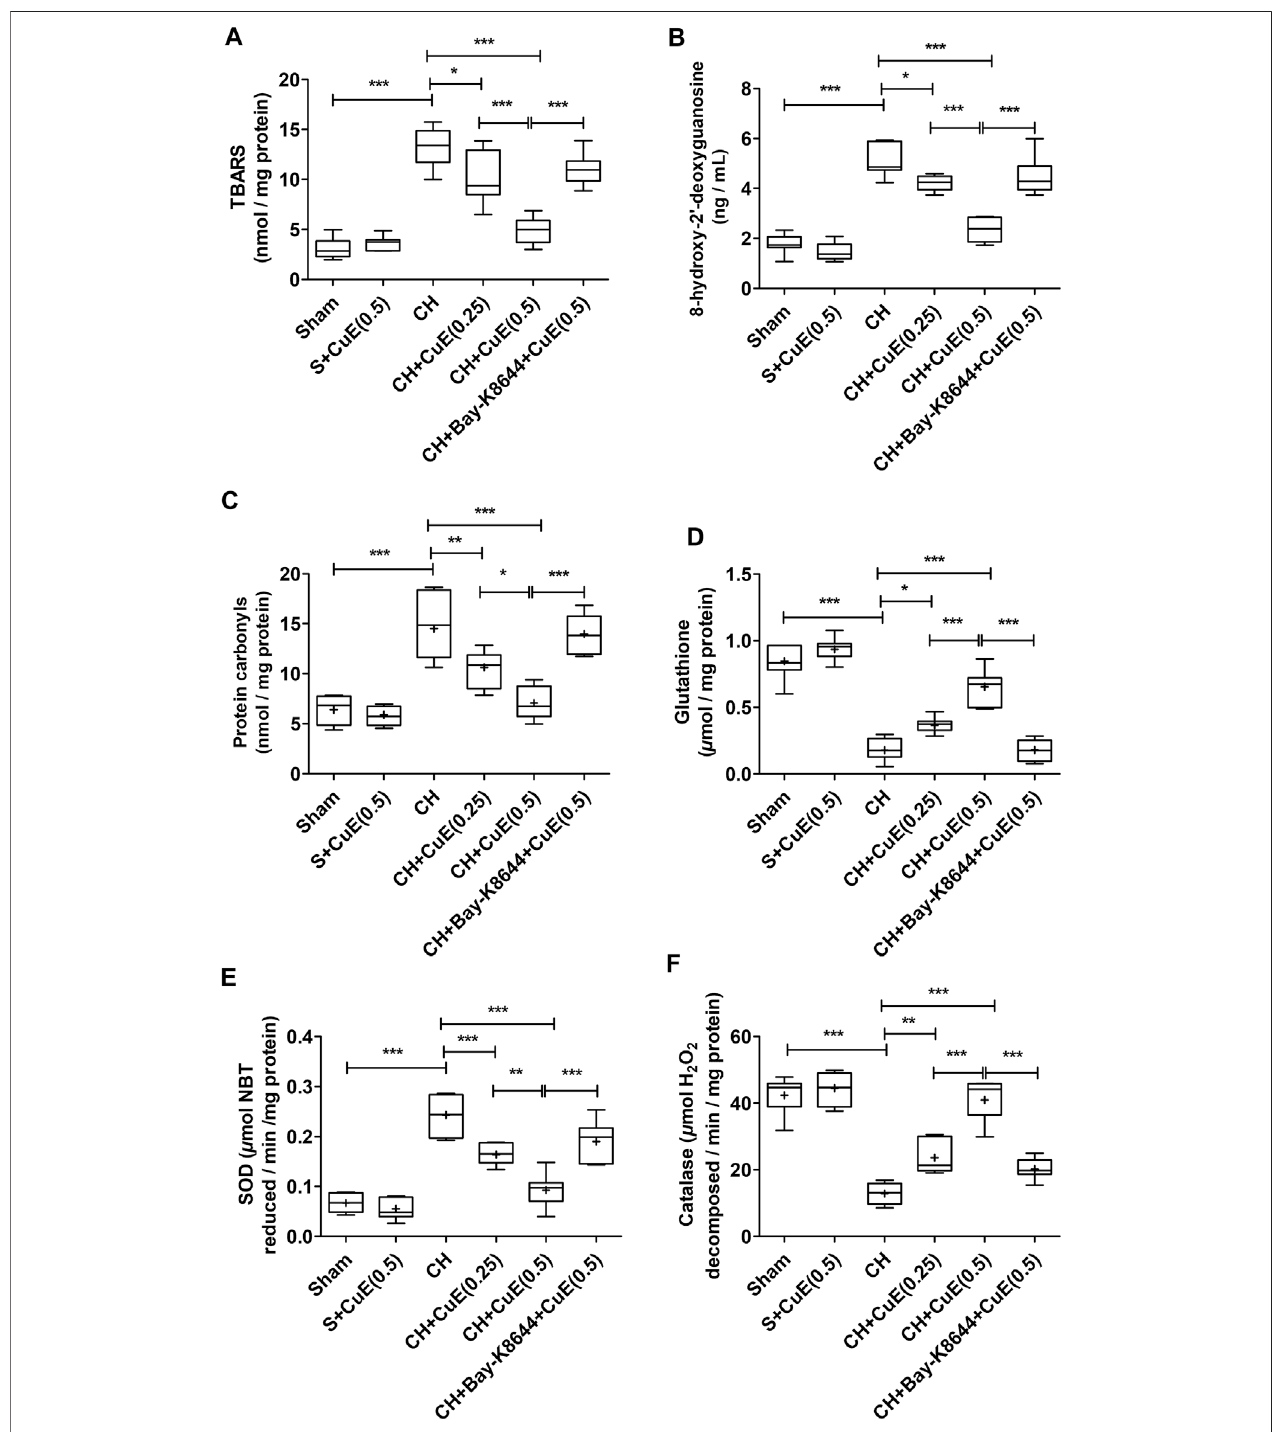
FIGURE 3 | CuE post-treatment (0.25 and 0.5 mg/kg, p.o. ) for 28 days decreased oxido-nitrosative stress against CH. CuE signi fi cantly decreased the brain (A) lipid peroxidation (TBARS) level, (B) 8-hydroxy-2 ’ -deoxyguanosine (8-OHdG) content, and (C) protein carbonyls levels. A signi fi cant increase in (D) GSH content, (E) SOD activity, and (F) catalase activity was observed in CuE-treated rats subjected to CH on day 1. Bay-K8644 attenuated antioxidant activity of CuE. Box and whisker plots (Tukey) show mean (+), median (bold horizontal line), quartiles (box), and total range (whisker) ( n (cid:1) 7). * ( p < .05), ** ( p < .01), *** ( p < .001)